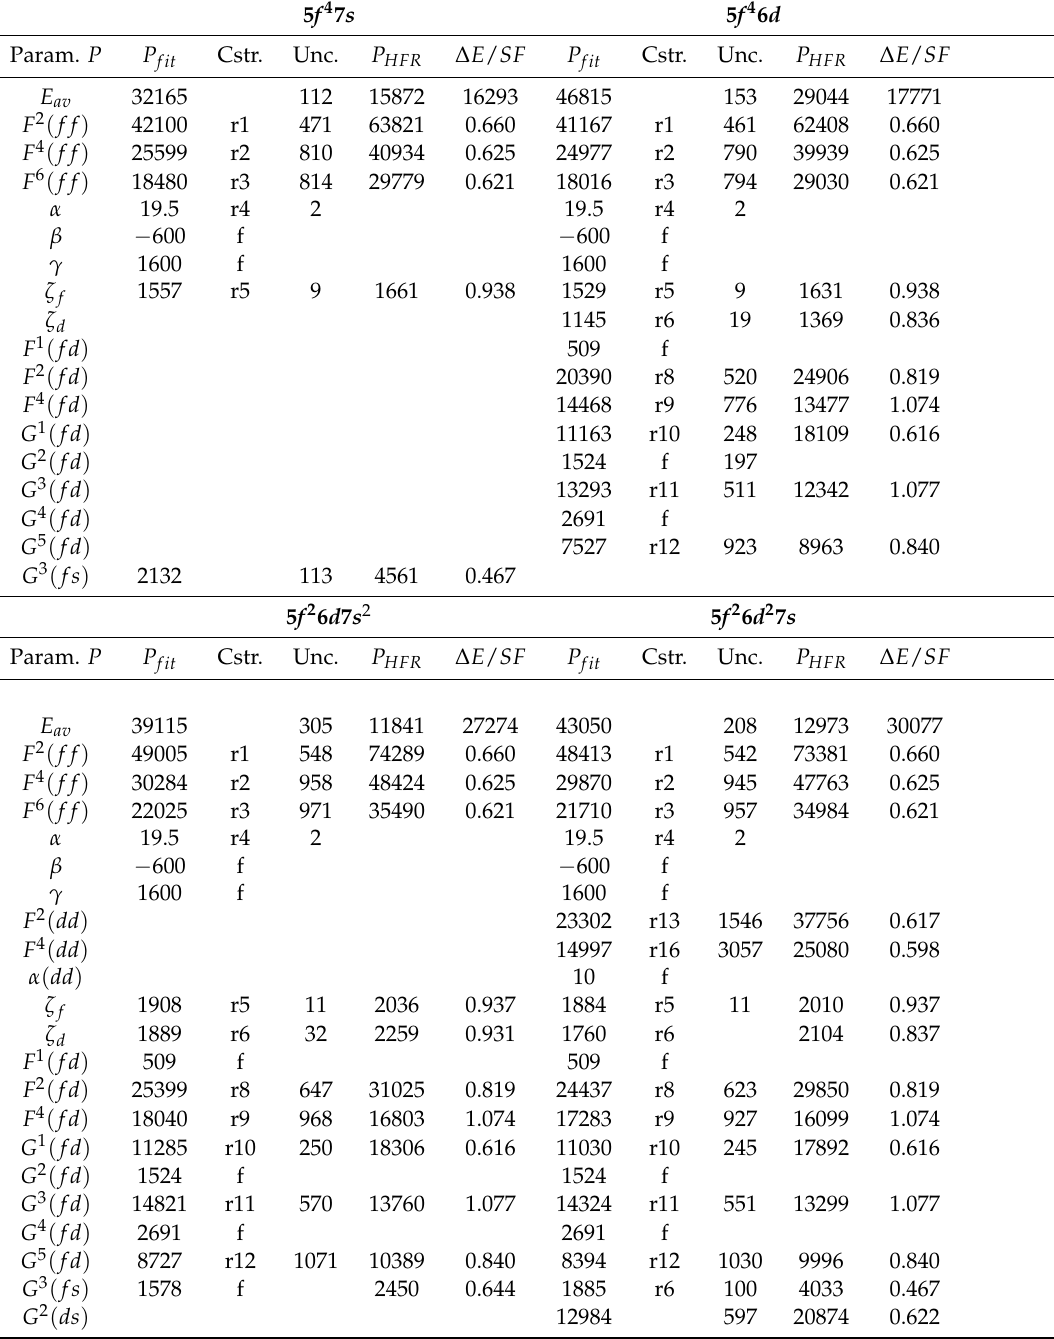
Table 5. Fitted parameters (in cm − 1 ) for even parity configurations of U II with 5 f 2 and 5 f 4 cores compared with HFR radial integrals. The scaling factors are SF ( P ) = P fit / P HFR (dimensionless). They are replaced by ∆ E = E fit − E HFR for E av average energies (in cm − 1 ). Constraints on some parameters are in the ’Cstr’ columns (denoted ’f’ for fixed parameters or ’rn’ , which link parameters of the same ’rn’ to vary in a constant ratio). The HFR values of E av parameters are relative to the lowest odd configuration 5 f 3 7 s 2 taken as zero